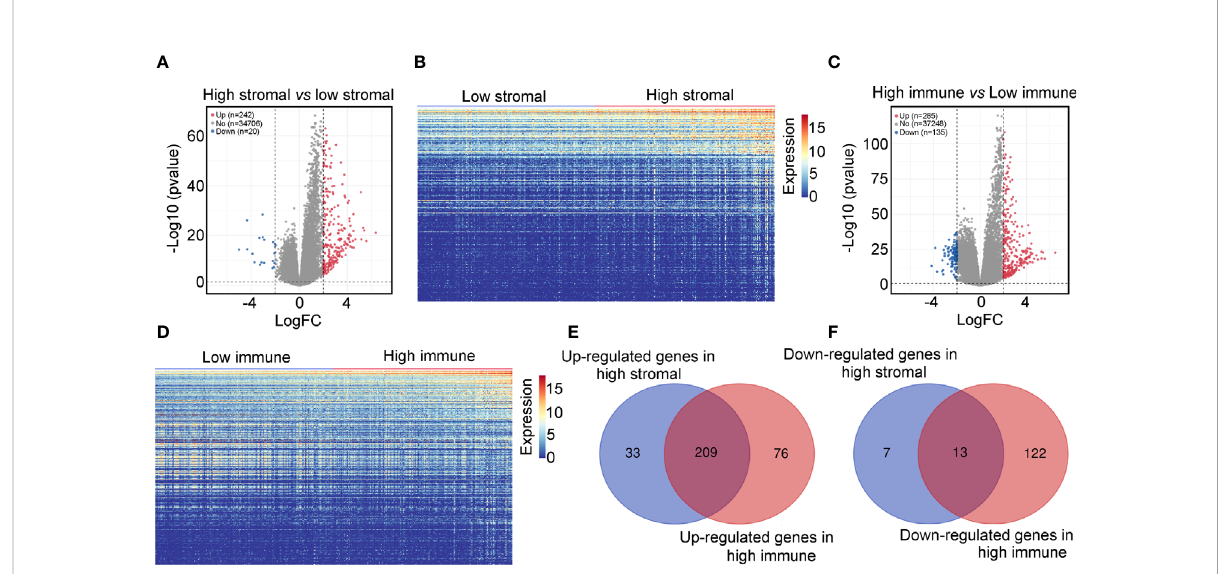
FIGURE 2 Differentially expressed genes in high- and low-stromal/immune-score group IDH1mt-glioma tissues. (A) Volcano plot demonstrating the differential expression of genes in high- and low-stromal group of IDH1mt-glioma tissues. (B) Heatmap plot showing DEGs between high- and low-stromal group of IDH1mt-glioma tissues. (C) Volcano plot demonstrating the differential expression of genes in high- and low-immune group of IDH1mt-glioma tissues. (D) Heatmap plot showing DEGs between high- and low-immune group of IDH1mt-glioma tissues. (E) Overlapping upregulated genes between high-stromal and -immune group of IDH1mt-glioma tissues. (F) Overlapping downregulated genes between high-stromal and -immune group of IDH1mt-glioma